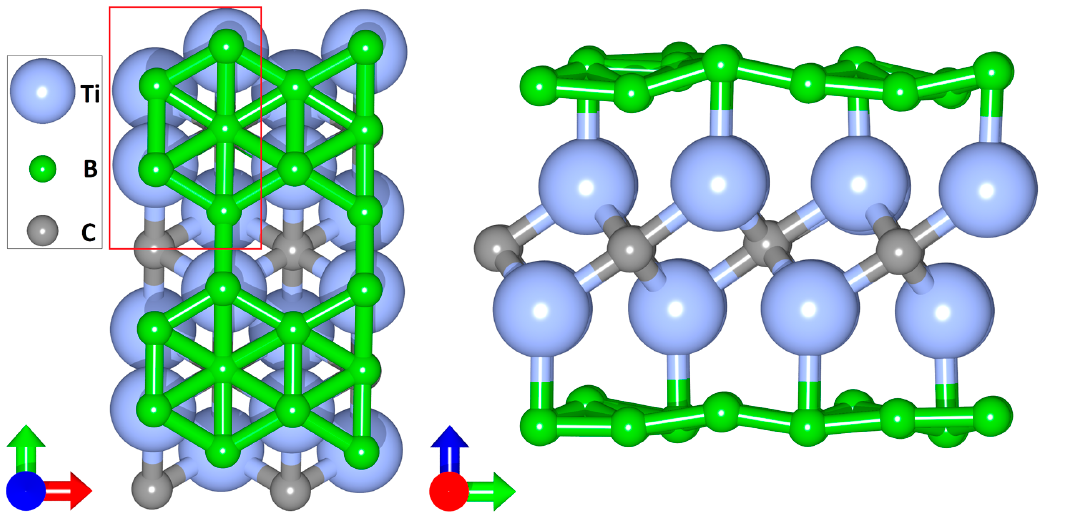
Figure 1. The supercell of a composite structure, Ti 16 C 8 B 40 , in the form of covalently bonded Ti 2 C and borophene B 12 . The left side of the figure shows the view of the structure in the XY plane; the right side is in the YZ plane.